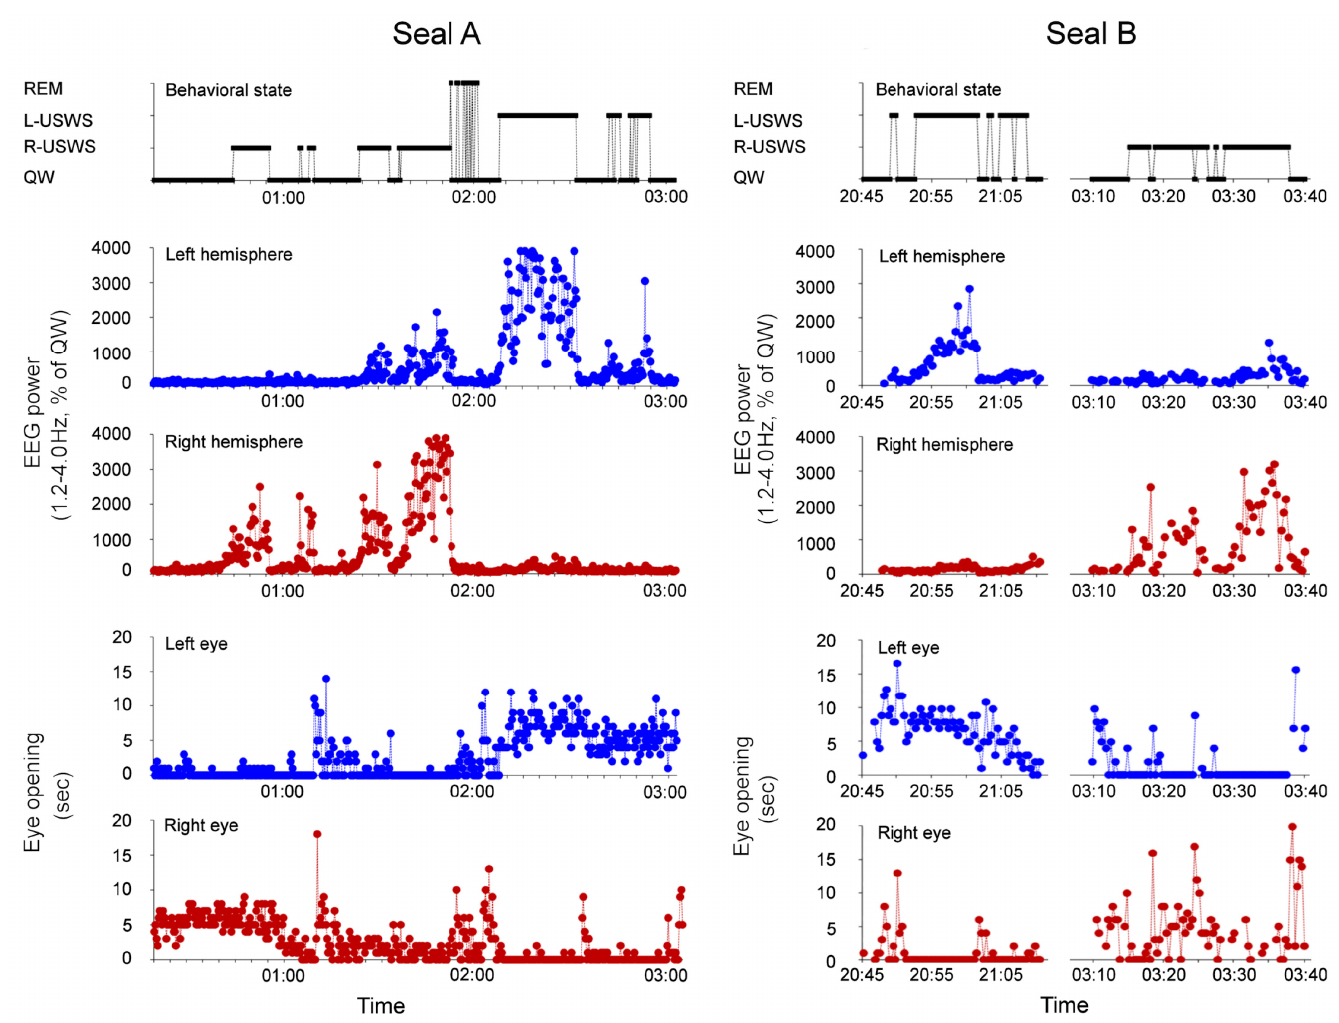
Fig 2. Association between EEG power and eye state in fur seals sleeping in seawater in a prone position. Diagrams show behavioral state scored as QW, R-USWS, L-USWS and REM sleep, then standardized EEG power in the range of 1.2–4.0 Hz in the left and right hemispheres (shown as percent of the average power in QW in the corresponding hemisphere) and the amount of time during which the left and right eye were open in corresponding 20-sec epochs in 2 fur seals (A and B) during sleep in a prone position. Several episodes of USWS in fur seal A occurred within one rest period first in the left and then in the right hemisphere. Two episodes of USWS in seal B (L-USWS and then R-USWS) were recorded for one night. Dotted lines connect markers representing data for consecutive 20-sec epochs. Several interruptions mark gaps when the data were not collected (due to artifacts in the EEG caused immersion of the head into the water or when the eyes were not visible).